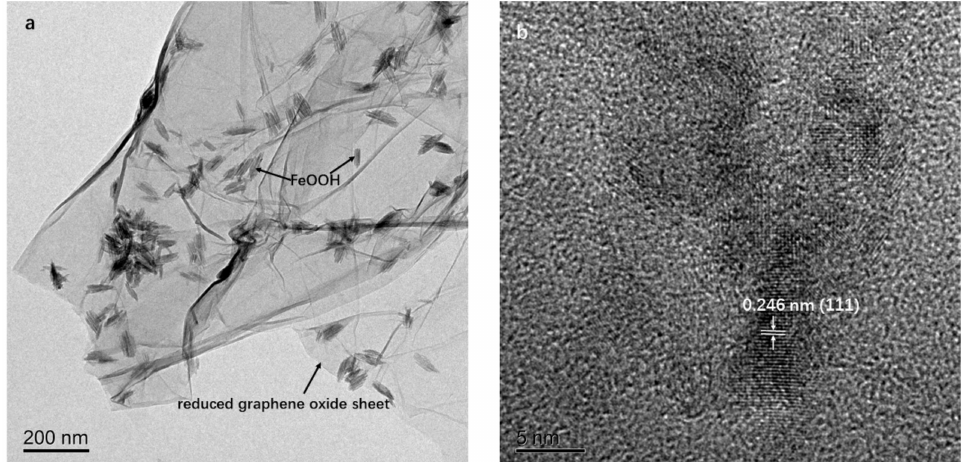
Figure 2. The typical TEM image of FeOOH-GA 0.25 ( a ). The HRTEM image of FeOOH-GA 0.25 ( b